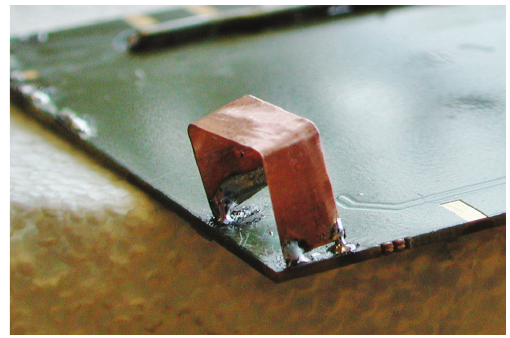
Figure 11: Antenna miniaturization demonstrator, top view.